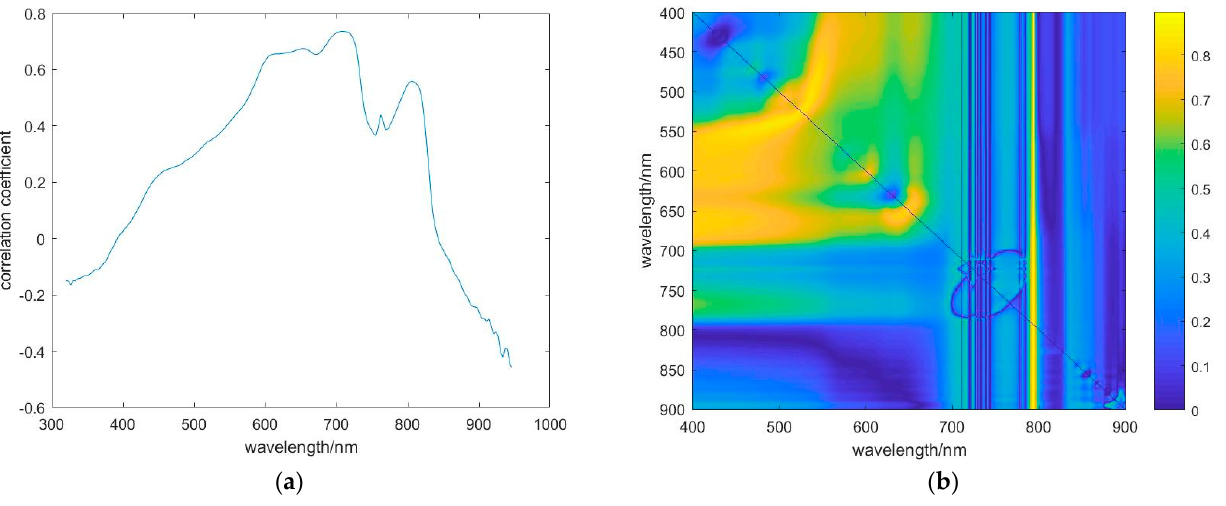
Figure 7. Pearson correlation analysis of single band, band ratio, and chlorophyll a concentration: ( a ) single band; ( b ) band